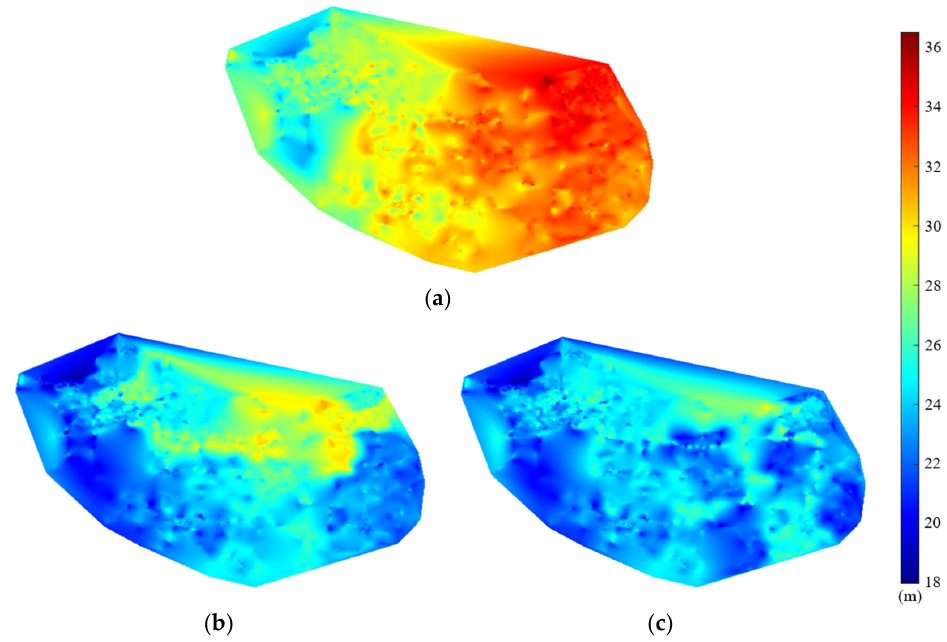
Figure 7. Pressure distribution in valley demand period: ( a ) Original; ( b ) Scheme A; ( c ) Scheme